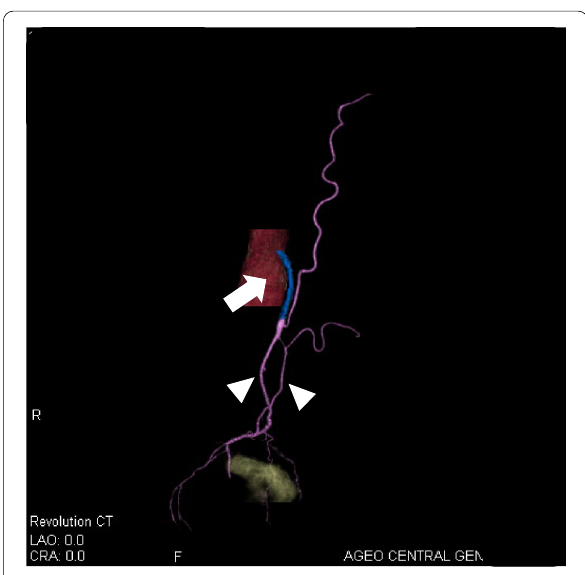
Fig. 5 CT angiography revealed occlusion of the aorta just below the origin of the inferior mesenteric artery (white arrow) and the dominant vessels of the tumor were identified as SRA and S2 (white arrowhead)